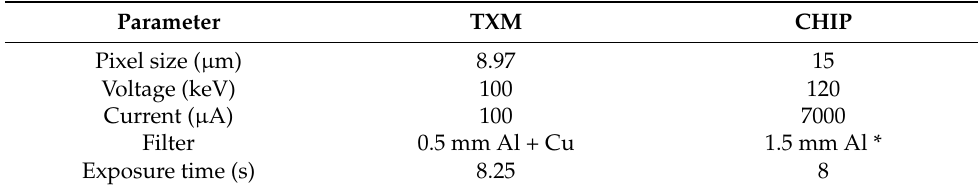
Figure 6. Concentration profiles at different ponding times for a single paste sample. Table 4. Settings used in TXM and CHIP imaging